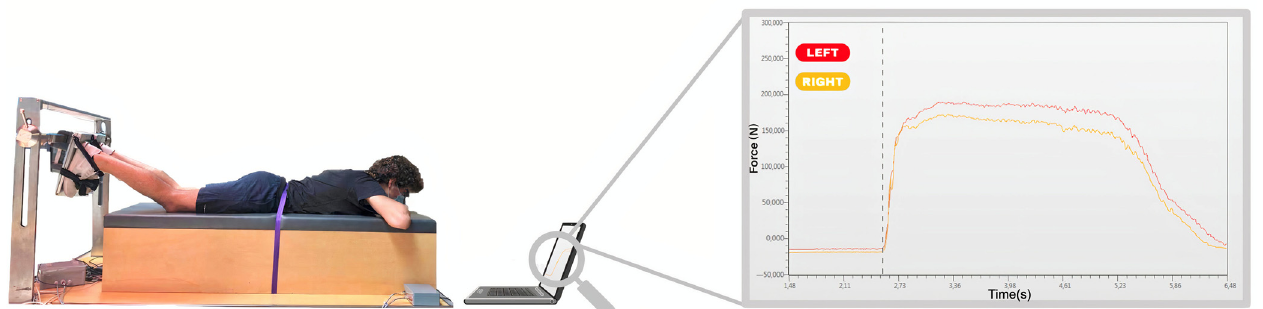
Figure 1. Experimental setup used to assess the knee flexors ’ peak torque and rate of torque development with 30° of knee flexion and neutral hip. DAQami layout measuring force (N) in the y ‐ axis and time (s) in the x ‐ axis, with the red line corresponding to the left limb and the yellow to the right limb, and the dashed line corresponding to the onset of force production (defined as the instant where the torque value reached three standard deviations above the baseline value).